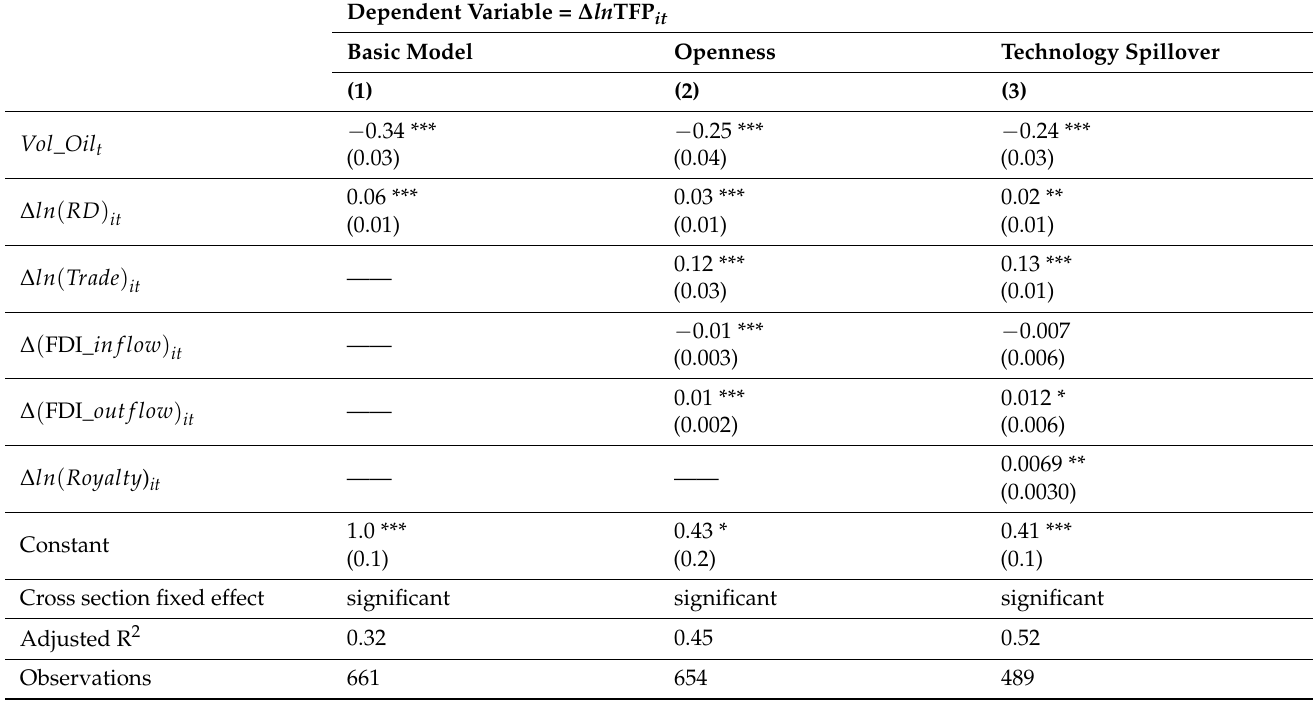
Table 3. The estimated effect of global and domestic factors on TFP growth for EU28 (refers to EU members as of the end of